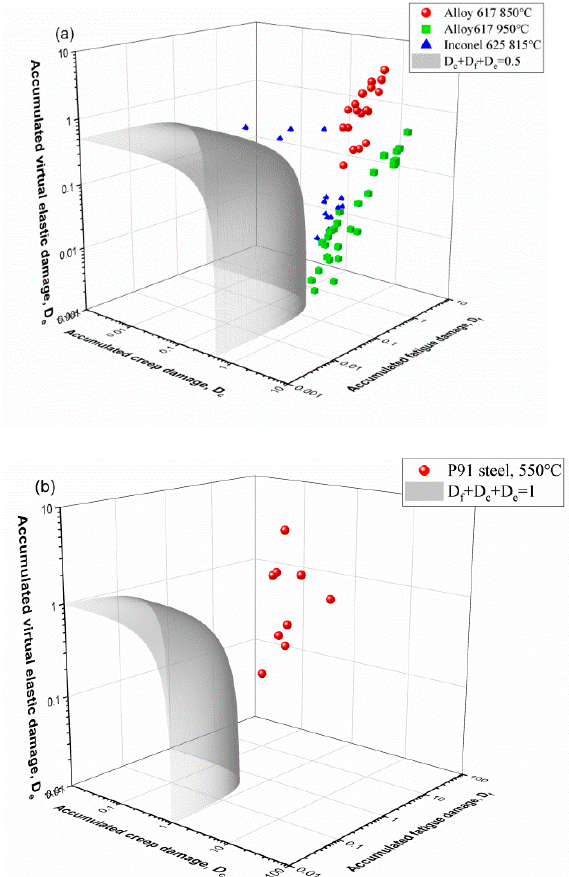
Figure 9. Damage interaction diagrams ( a ) Alloy 617 at 850 °C and 950 °C, Inconel 625 at 815 °C and ( b ) P91 steel at 550 °C.